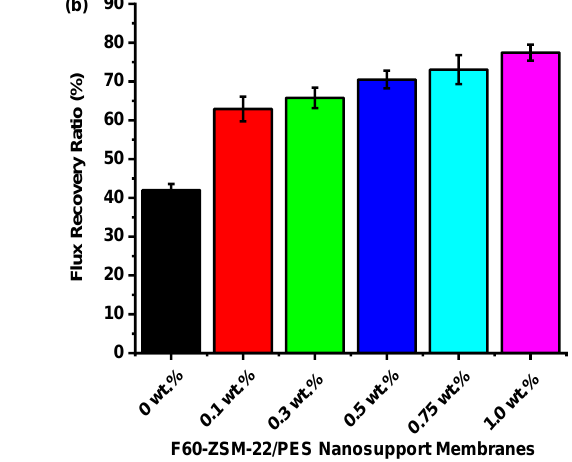
Figure 11. Flux recovery ratios analysis of nanofiltration membranes prepared via phase inversion to nominal wt.% loadings of 0, 0.1, 0.3, 0.5, 0.75, and 1.0 using ZSM-22 zeolite as nanoadditives: ( a ) C60-ZSM-22/PES and ( b ) F60-ZSM-22/PES.